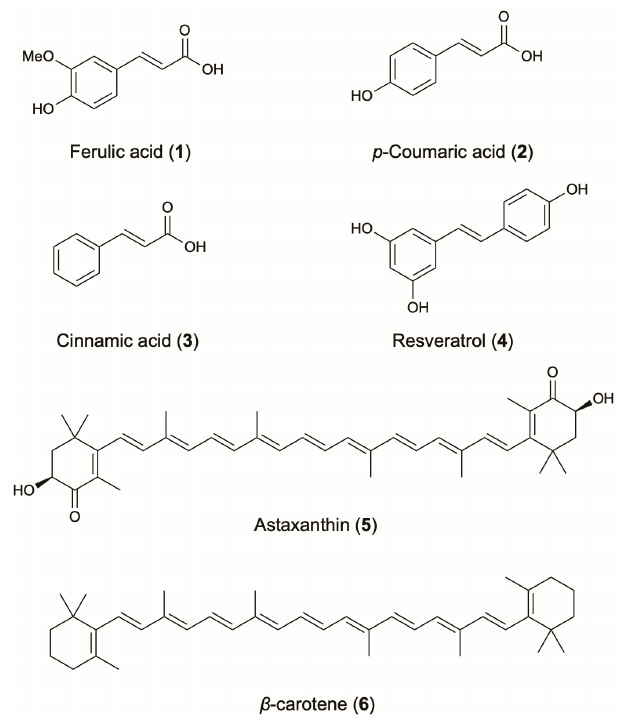
Figure 2. Antioxidant agents from terrestrial microorganisms.